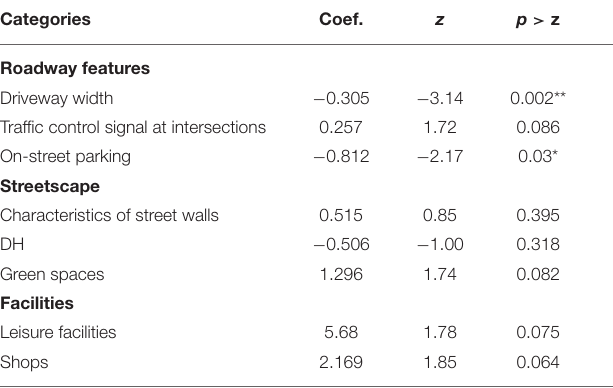
TABLE 5 | Conditional logit results of chosen and the least directional changed route (the part-route which deviated from the alternative